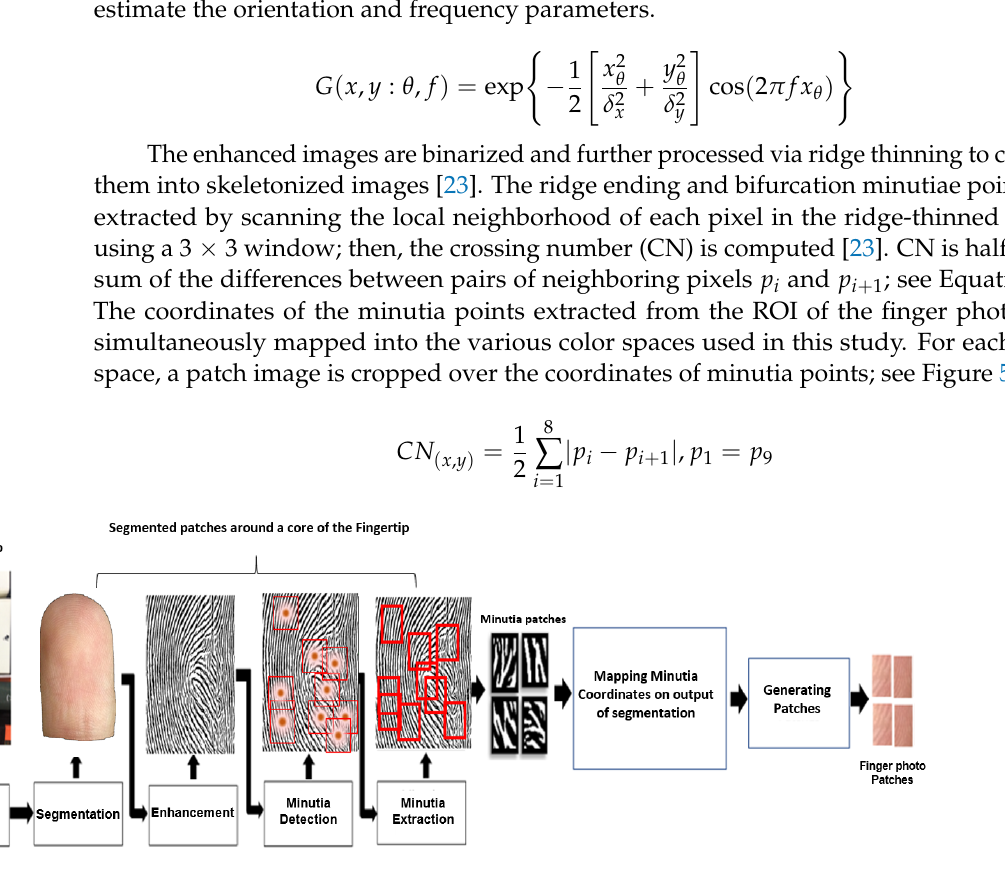
Figure 5. Architecture illustrating image segmentation, enhancement and minutia points